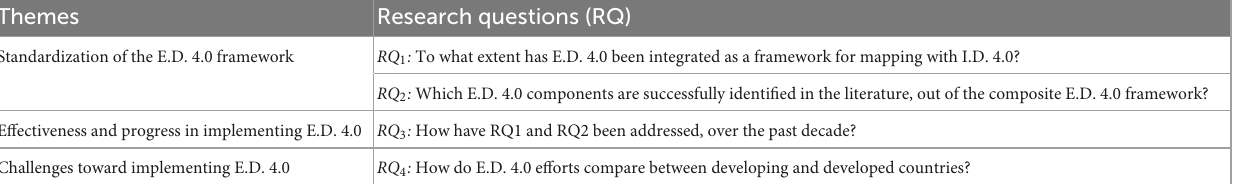
TABLE 5 Themes and research questions formulated to test the objectives, in the reference